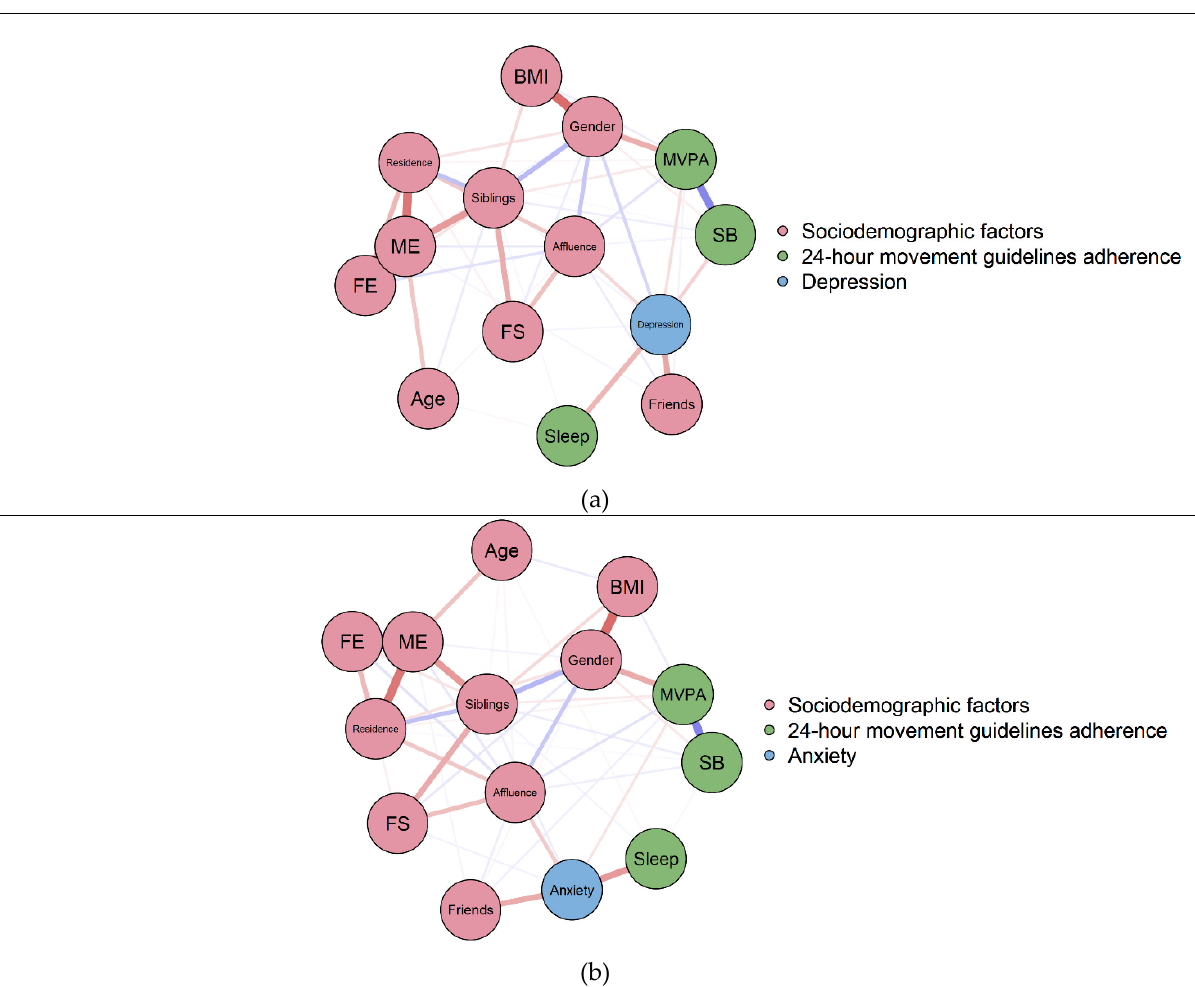
Figure 1. ( a ) Network displaying individual associations between 24-hour movement guidelines and depression. ( b ) Network displaying individual associations between 24-hour movement guidelines and anxiety. Note. Blue edges represent positive associations, and red edges represent negative associations. The thickness of the edges reflects the magnitude of the associations. BMI = body mass index; FS = family structure; FE = father’s education; ME = mother’s education; Siblings = number of siblings; Friends = number of friends; Affluence = perceived family affluence; Sleep = meet the sleep guideline or not; SB = meet the sedentary guideline or not; MVPA = meet the moderate-to-vigorous physical activity guideline or not.